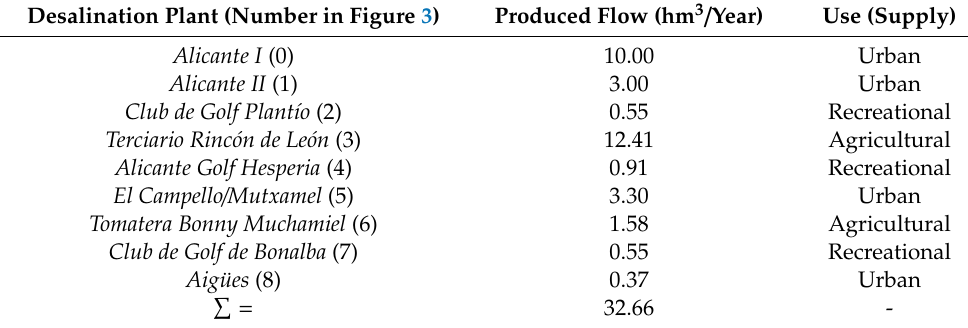
Table 3. Desalination installations identified in the study area and produced flows (hm 3 / year). Source: elaborated with private